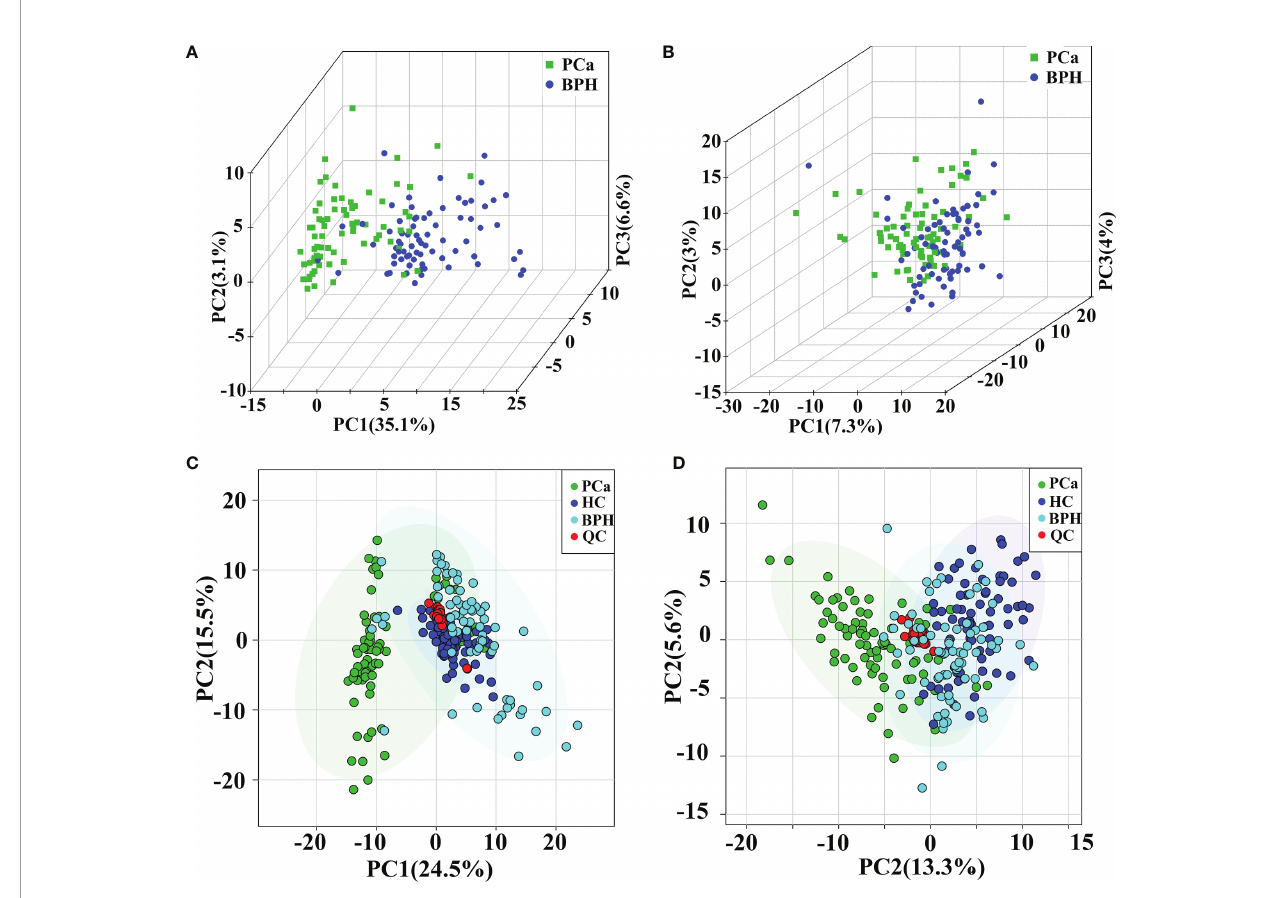
FIGURE 2 | PCA score plots in positive (A) and negative (B) ion modes between PCa and BPH groups. PCA score plots of QC samples in positive (C) and negative (D) ion modes among PCa, BPH, and HC groups. PCA, principal component analysis; PCa, prostate cancer; BPH, benign prostatic hyperplasia; QC, quality control; HC, healthy